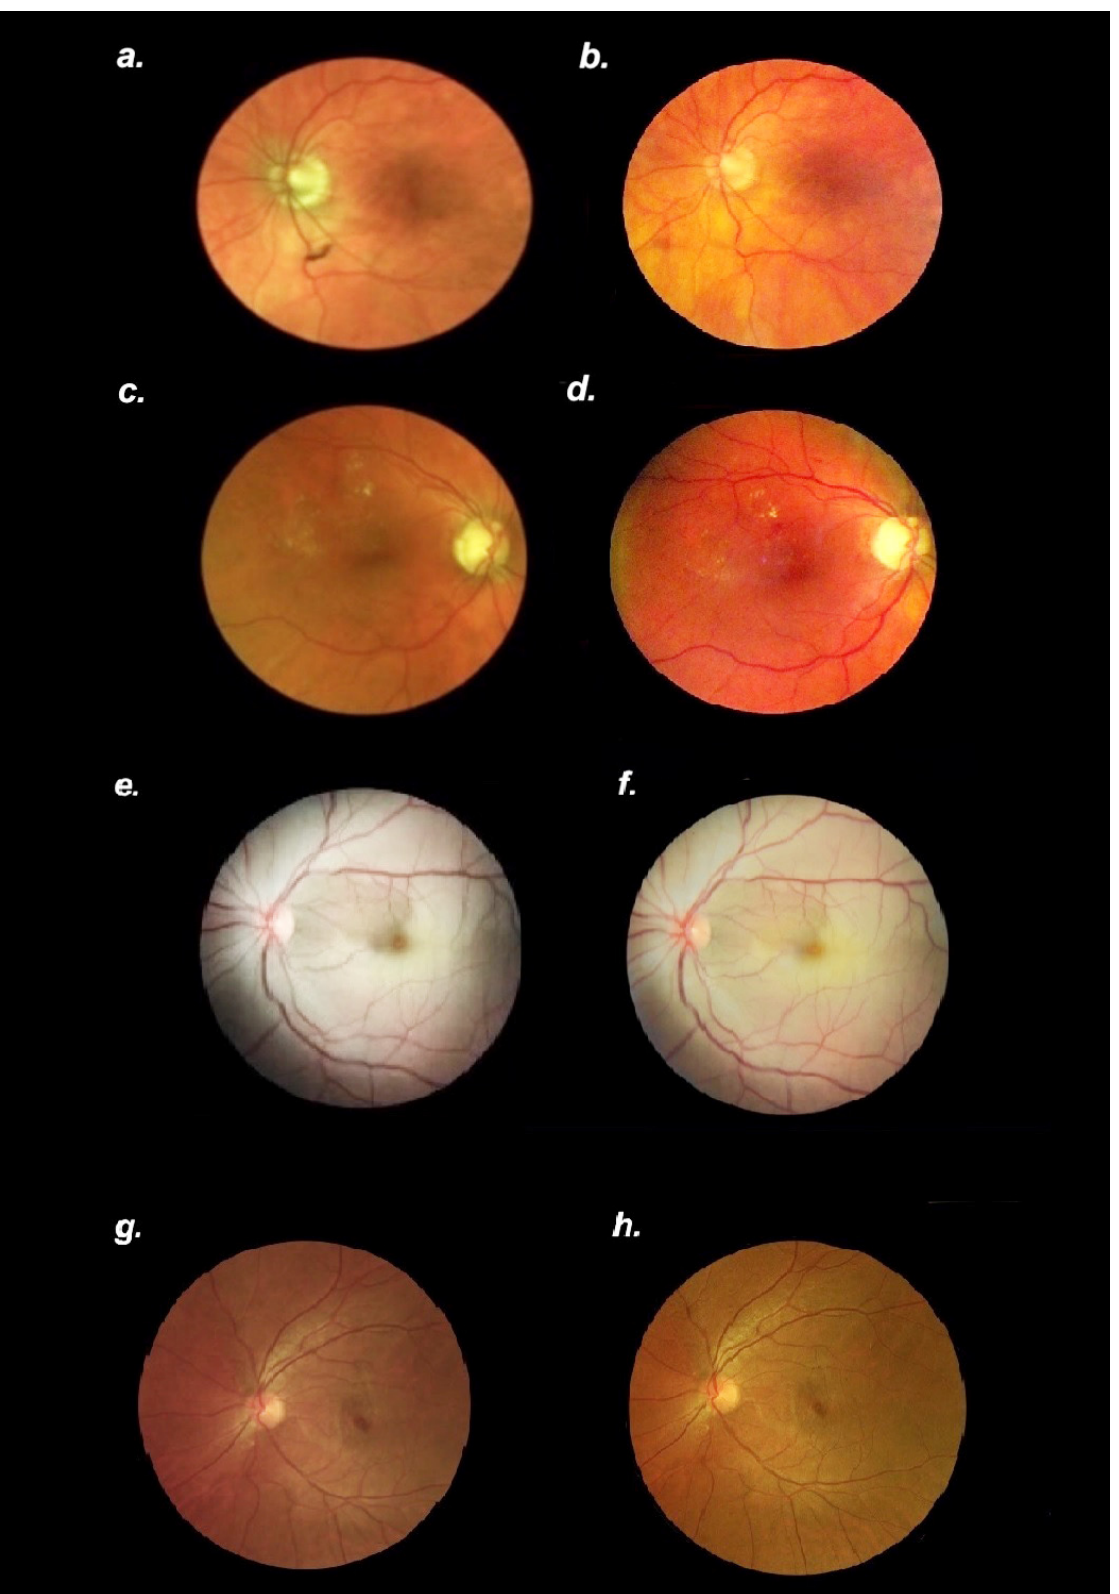
Figure 5. Side-by-side Comparison of Fundus Photography Utilizing the traditional fundus camera (Optos California) and Smartphone Retinal Imager. ( a ). Normal fundus photograph of a left eye